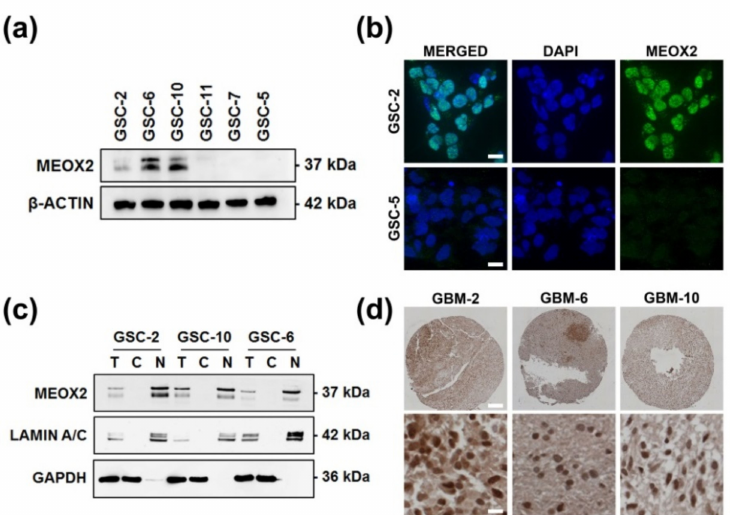
Figure 1. MEOX2 expression and localization among GSC. ( a ) Basal expression of MEOX2 in six GSC; ( b ) Representative immunofluorescence images of MEOX2 (green) in GSC-2 (dapi = blue C, Scale bar: 10 µ m); ( c ) Cell fractioning analysis of MEOX2 location in GSC-2, GSC-6, and GSC-10 lines (T = total, C = cytoplasmic, N = nuclear) with LAMIN A/C and GAPDH as controls corresponding to nuclear and cytoplasmic fraction respectively; ( d ) Immunohistochemical analysis of MEOX2 expression in tumors from which GSC originated (Scale bar =100 µ m for high panel and =10 µ m low